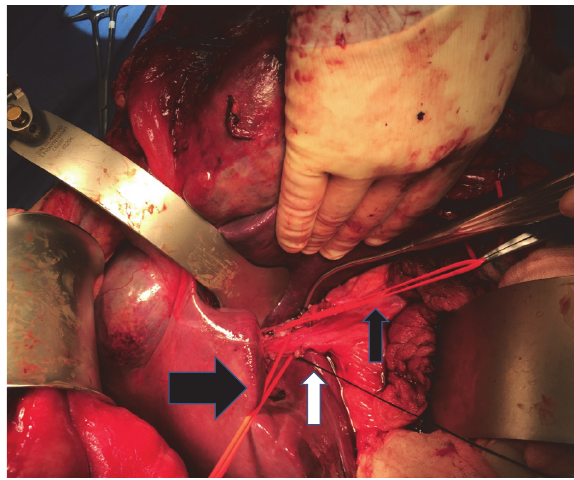
Figure 4: Small black arrow indicates vessel loop around the left portal vein. Large black arrow indicates loop around common hepatic bile duct. White arrow shows suture on cystic duct stump.